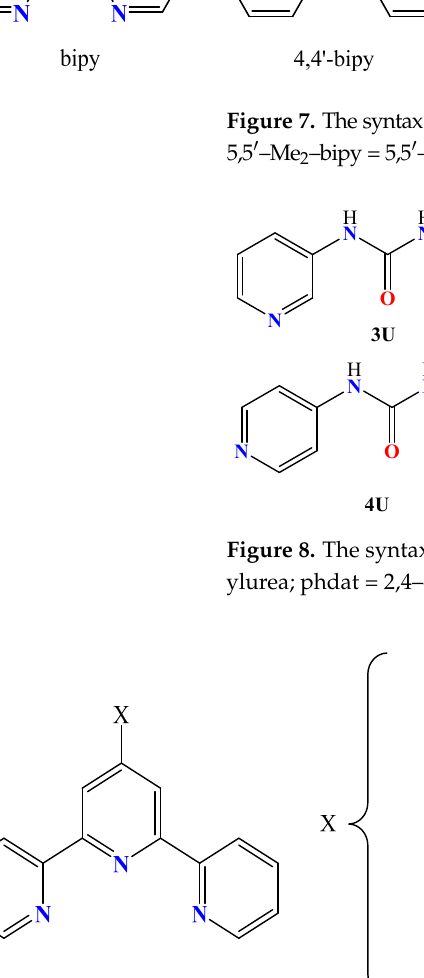
Figure 9. The syntax formula of 2,2 (cid:48) :6 (cid:48) ,2 (cid:48)(cid:48) –terpyridine derivatives: L1 = 4 (cid:48) –(4–tolyl)–2,2 (cid:48) :6 (cid:48) ,2 (cid:48)(cid:48) – terpyridine; L2 = 4 (cid:48) –(furan–2–yl)–2,2 (cid:48) :6 (cid:48) ,2 (cid:48)(cid:48) –terpyridine; L3 = 4 (cid:48) –(pyridin–3–yl)–2,2 (cid:48) :6 (cid:48) ,2 (cid:48)(cid:48) –terpyridine; L4 = 4 (cid:48) –(4–chlorophenyl)–2,2 (cid:48) :6 (cid:48) ,2 (cid:48)(cid:48) –terpyridine; L5 = 4 (cid:48) –(3,4–dimethoxyphenyl)–2,2 (cid:48) :6 (cid:48) ,2 (cid:48)(cid:48) –terpyridine and